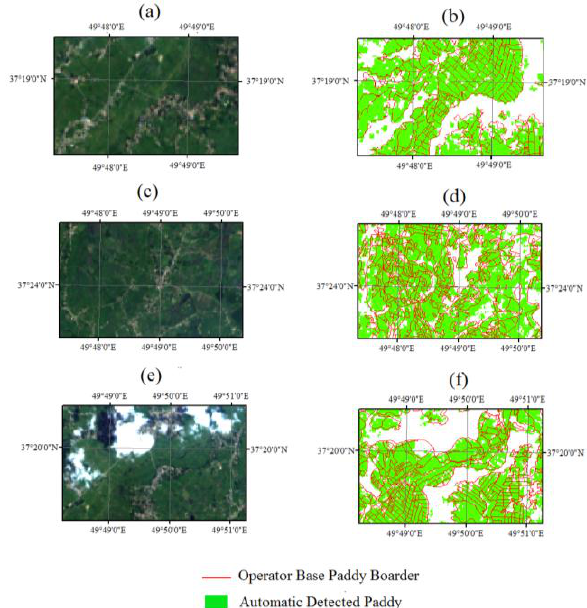
Figure 7. Comparison of Interface paddy detection and operator base